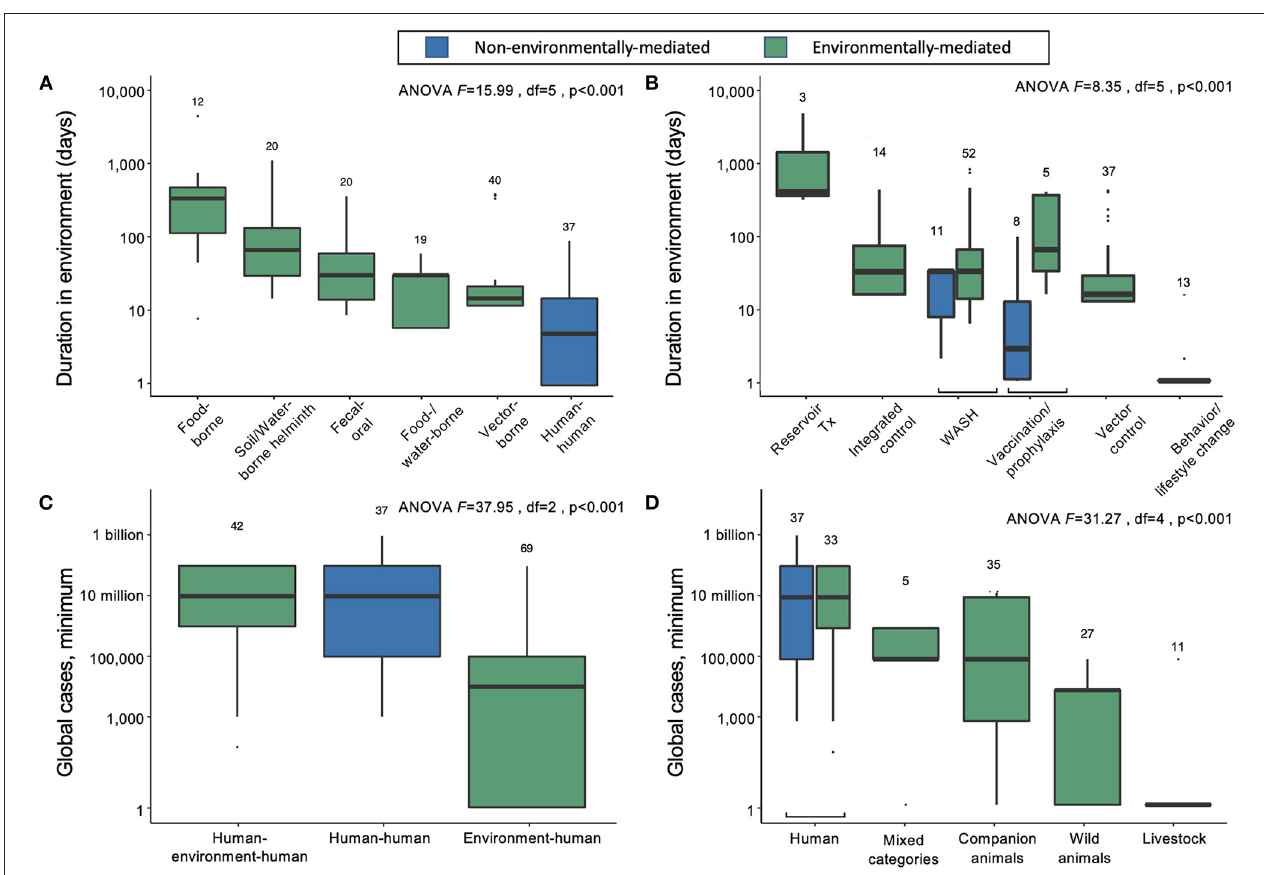
FIGURE 2 | (A) Duration of infectious stages outside primary vertebrate hosts (but including vertebrates as obligate intermediate hosts) according to primary transmission strategy, excluding normal flora/opportunistic pathogens and directly zoonotic pathogens, which were data-limited, and sapronoses, which persist indefinitely in abiotic reservoirs. (B) Duration of infectious stages outside primary vertebrate hosts according to standard strategies for disease prevention and control, excluding sapronoses. (C) The minimum estimated global cases according to obligate transmission pathways, categorized as direct human-to-human transmission (e.g., STDs), human-to-human transmission with obligate vertebrate stages (e.g., soil-transmitted helminths), and environment-to-human transmission (e.g., rabies virus). (D) The minimum estimated global cases by obligate vertebrate host ranges; mixed category includes some combination of livestock, poultry, domestic animals, wild animals (including birds), or